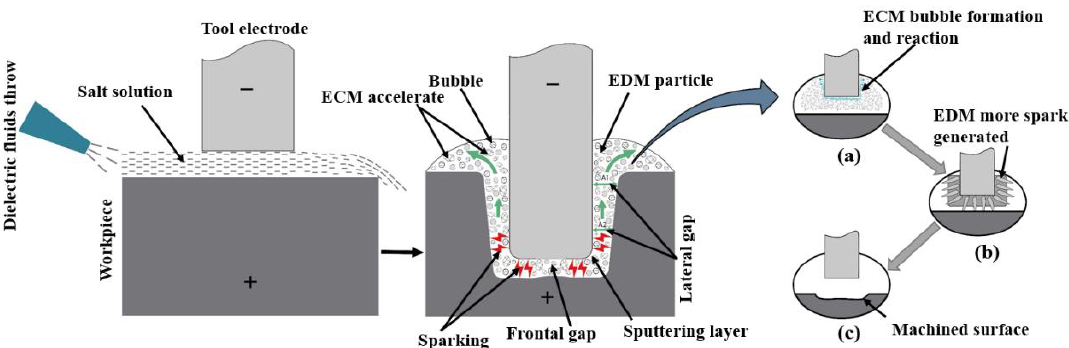
Figure 1. Schematic diagram of tool electrode high-speed electrochemical discharge machining mechanism. ( a ) ECM bubble formation and reaction, ( b ) EDM spark generating ( c ) Machined surface